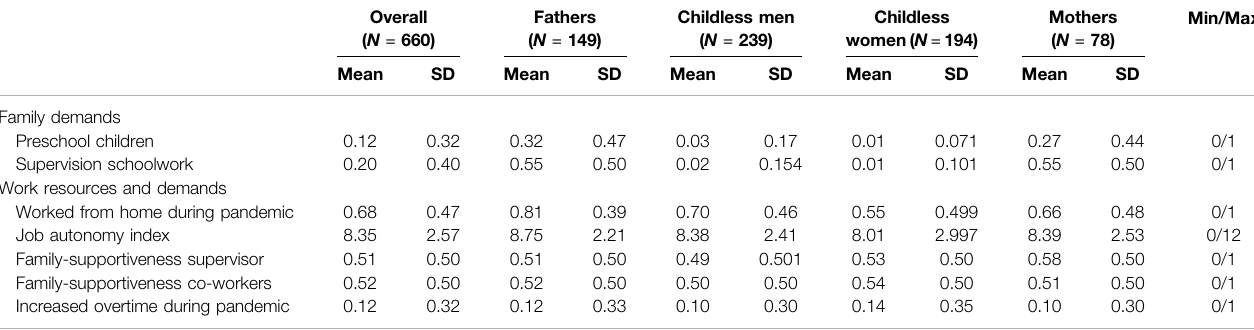
TABLE 1 | Descriptive statistics family and work resources and